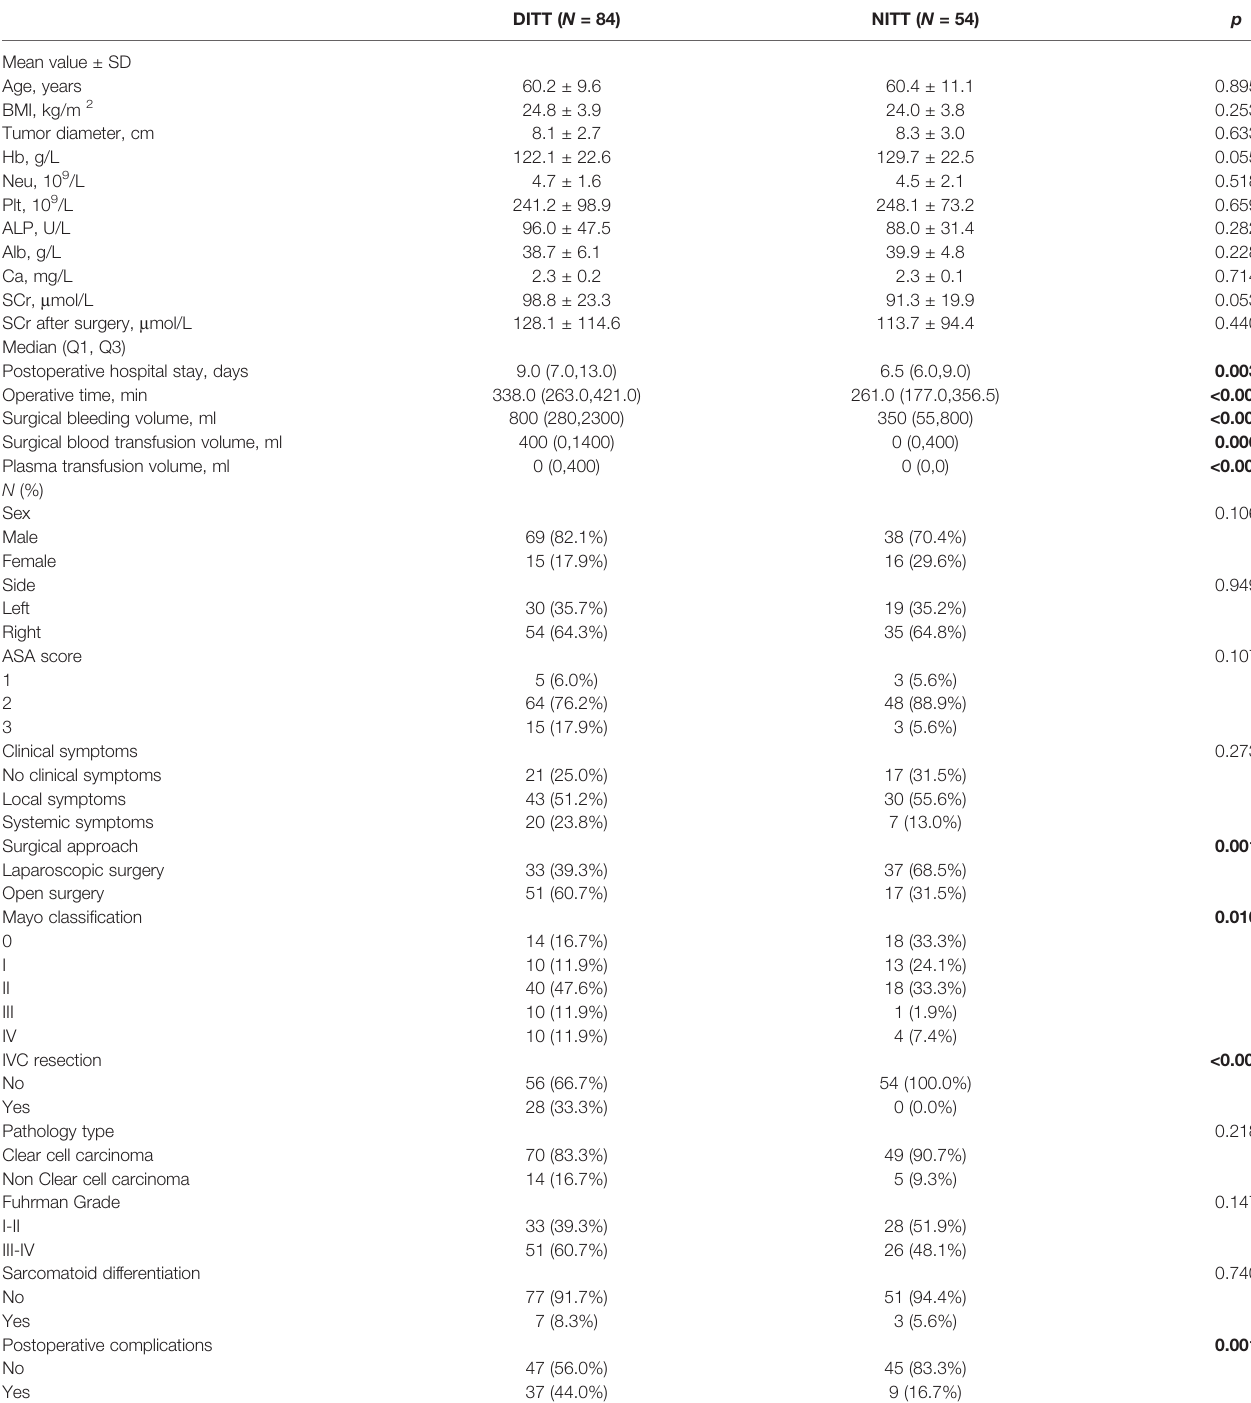
TABLE 1 | Comparison of clinical and pathologic features between the Deep Invasive Tumor Thrombus (DITT) group and the Non-Invasive Tumor Thrombus (NITT)